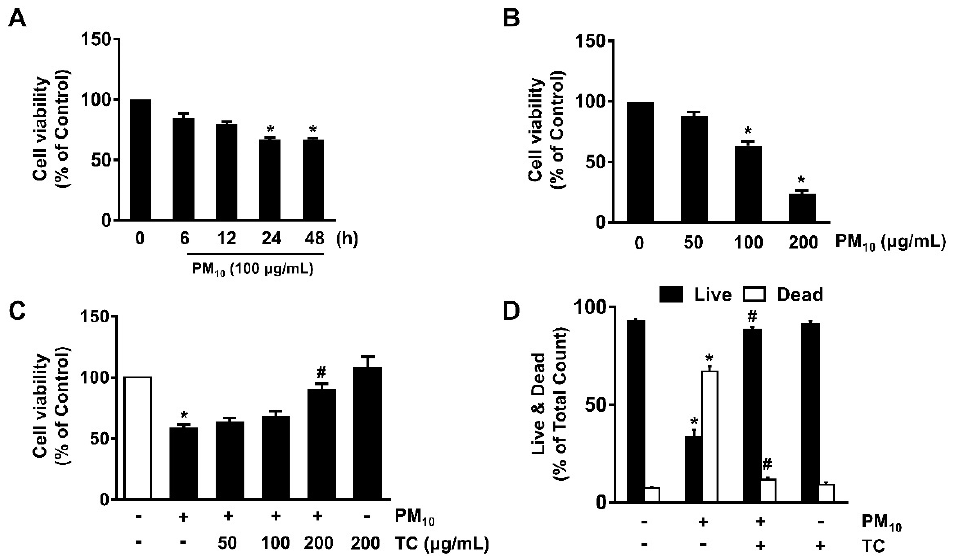
Figure 1. Tart cherry prevents the keratinocyte apoptosis induced by fine particulate matter (PM 10 ). ( A ) Time-dependent response of PM 10 (100 µ g/mL) on cytotoxicity was determined by EZ-CYTOX assay. Data are represented as the means ± S.E. * p ≤ 0.05 vs. 0 h. ( B ) Cells treated with PM 10 (0–200 µ g/mL) for 24 h. Data are represented as the means ± S.E. n = 3. * p ≤ 0.05 vs. control. ( C ) Cells co-treated with tart cherry and PM 10 for 24 h. Data are represented as the means ± S.E. n = 3. * p ≤ 0.01 vs. control. # p ≤ 0.01 vs. PM 10 alone. ( D ) Cells incubated with tart cherry and PM 10 for 24 h. Live and dead cells were determined by the live/dead assay kit. Data are represented as the means ± S.E. n = 3. * p ≤ 0.001 vs. control. # p ≤ 0.05 vs. PM 10 alone.